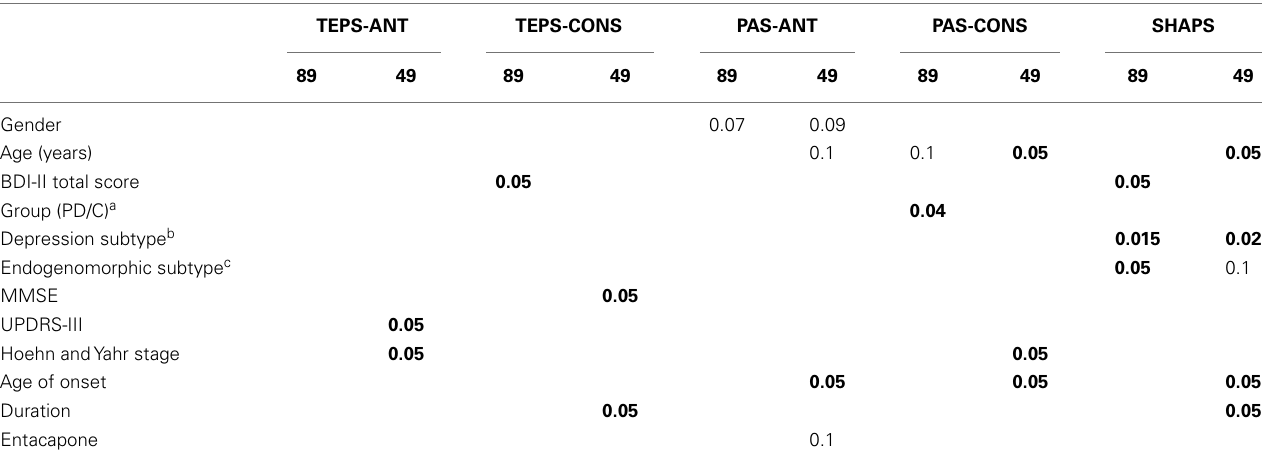
Table 2 | Univariate associations between socio-demographic variables, depression, and anhedonia scales for the entire sample ( N = 89) or for the Parkinson’ group ( N =